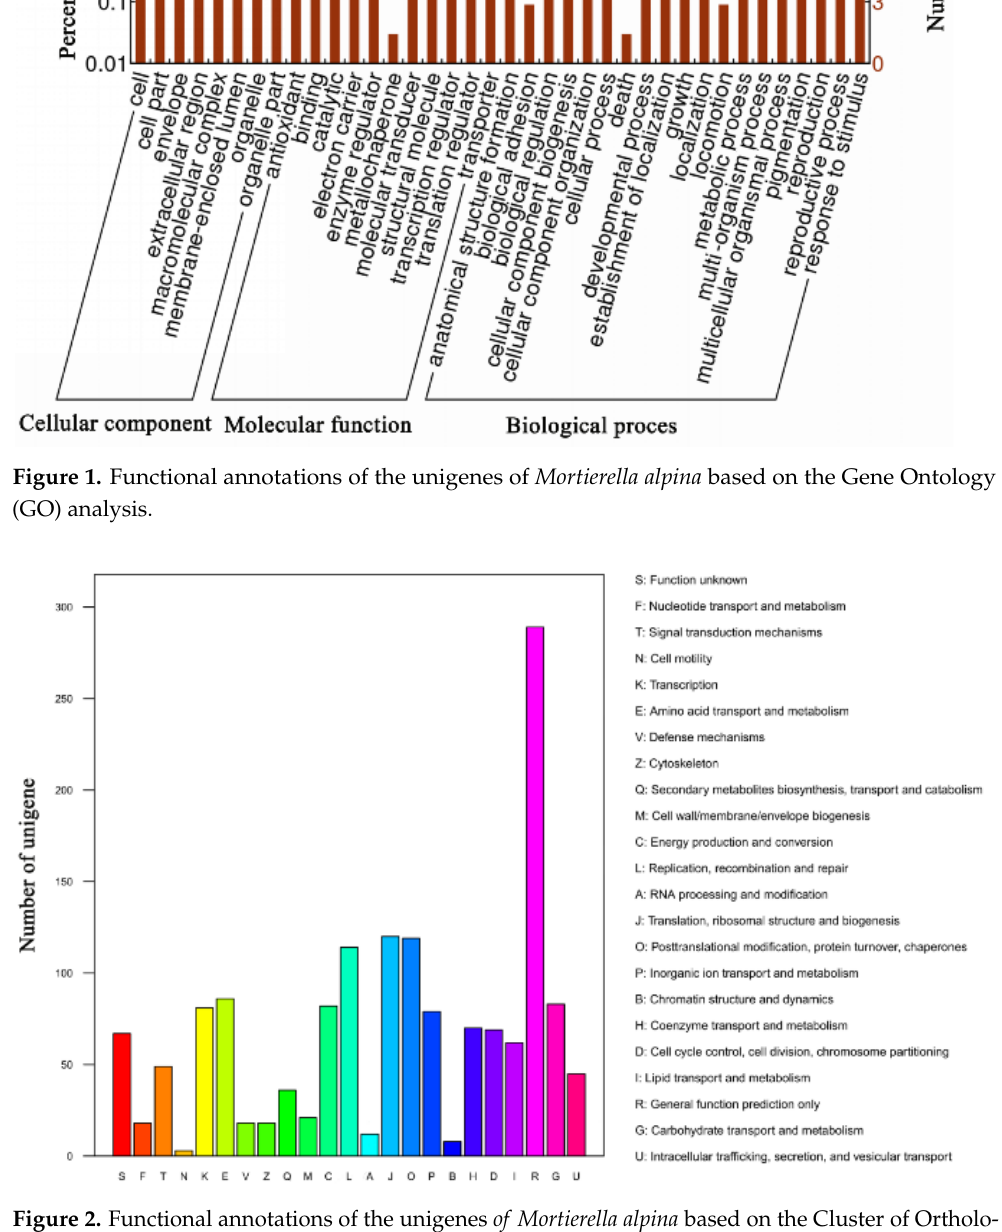
Figure 1. Functional annotations of the unigenes of Mortierella alpina based on the Gene Ontology (GO) analysis.